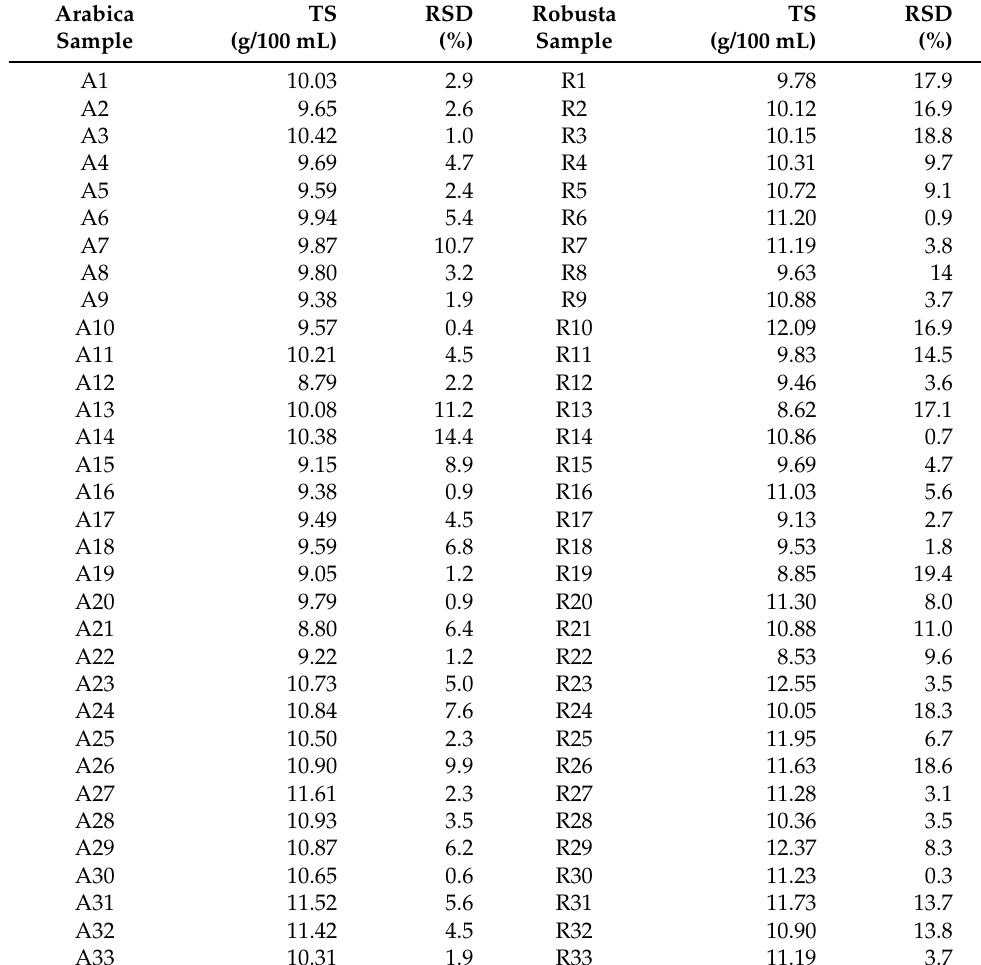
Table 2. Content of total solids (TS) (g/100 mL) found in different EC samples, Arabica and